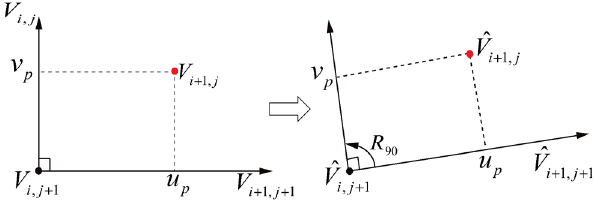
Fig. 3 Shape preservation by as-similar-as-possible transformation with the same local